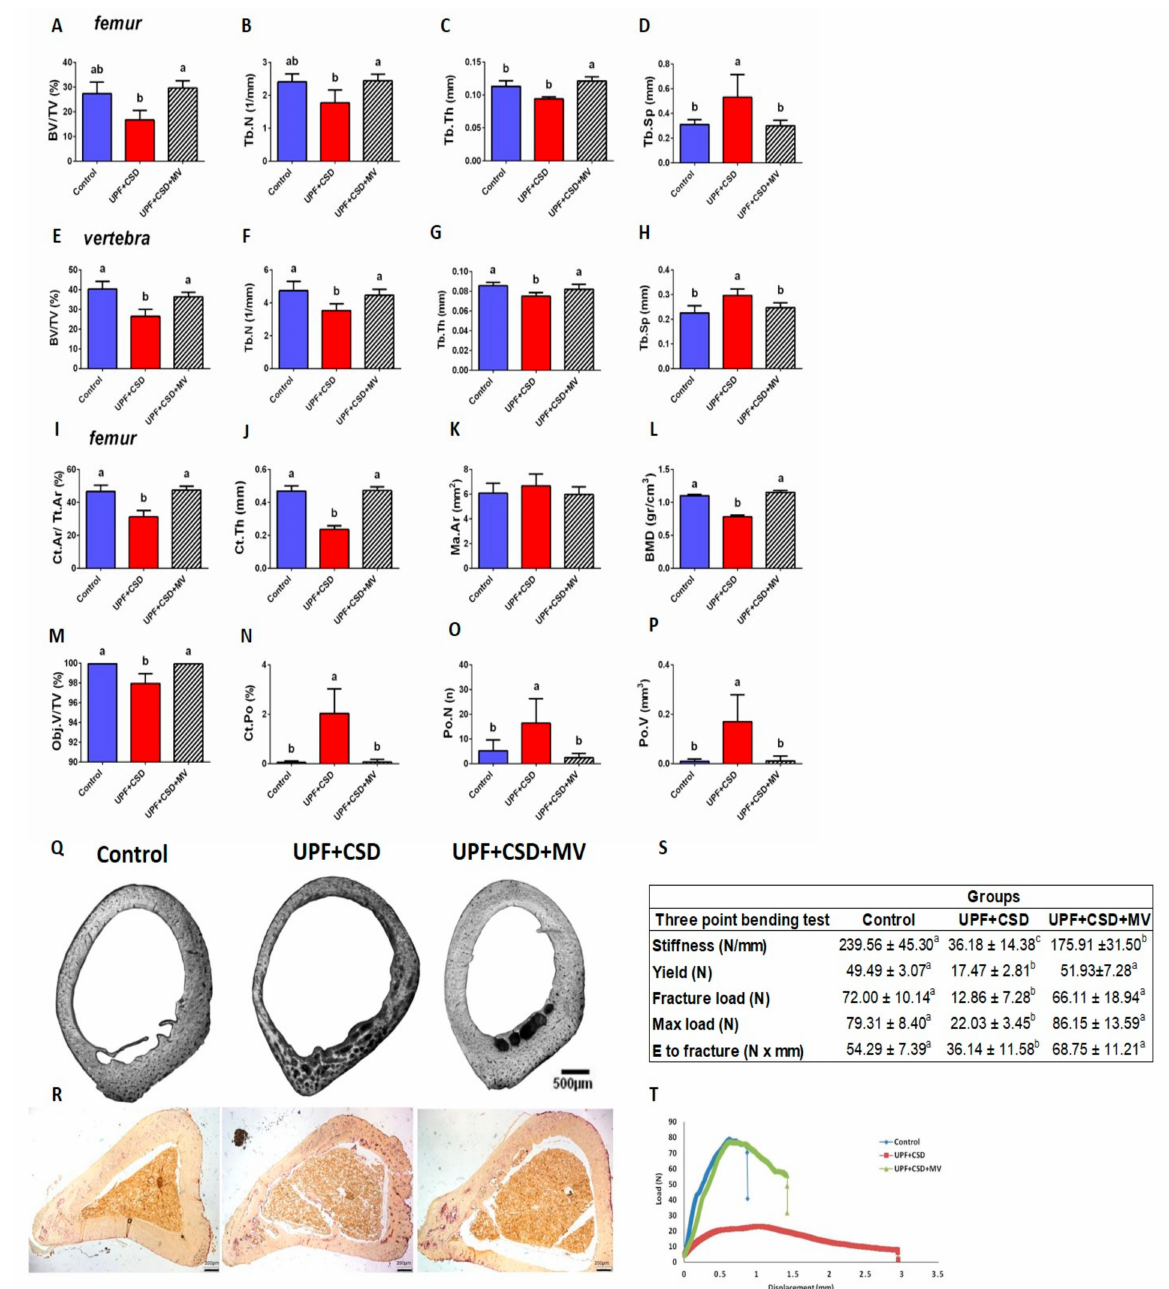
Figure 2. Supplementation of ultra-processed food (UPF) with multi-vitamins and minerals restores bone morphometry and mechanical properties. Control and UPF groups were compared to a group receiving an ultra-processed food (UPF) diet with multi-vitamin and minerals (UPF + CSD + MV). Femora bones were scanned in a SkyScan 1174 X-ray computed microtomograph scanning device and were analysed for trabecular and cortical properties. ( A – H ) Trabecular parameters: bone volume fraction (BV/TV), trabecular thickness (Tb.Th), trabecular number (Tb.N), and trabecular